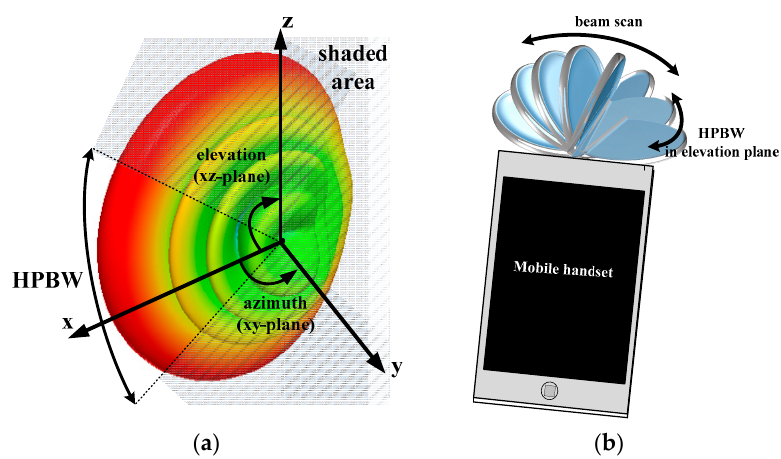
Figure 1. The azimuth and elevation plane versus the radiation pattern: ( a ) half power beam width (HPBW) in the elevation plane and shaded area; ( b ) hemispheric beam coverage required by mobile handsets.